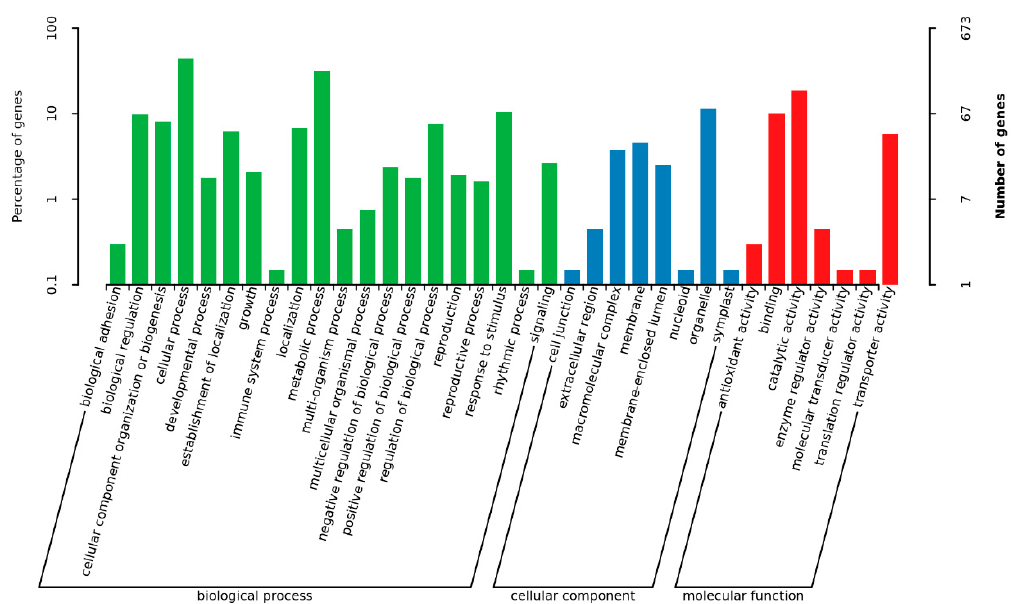
Figure 6. Functional grouping of differentially expressed genes in the ∆ moade12 mutant.